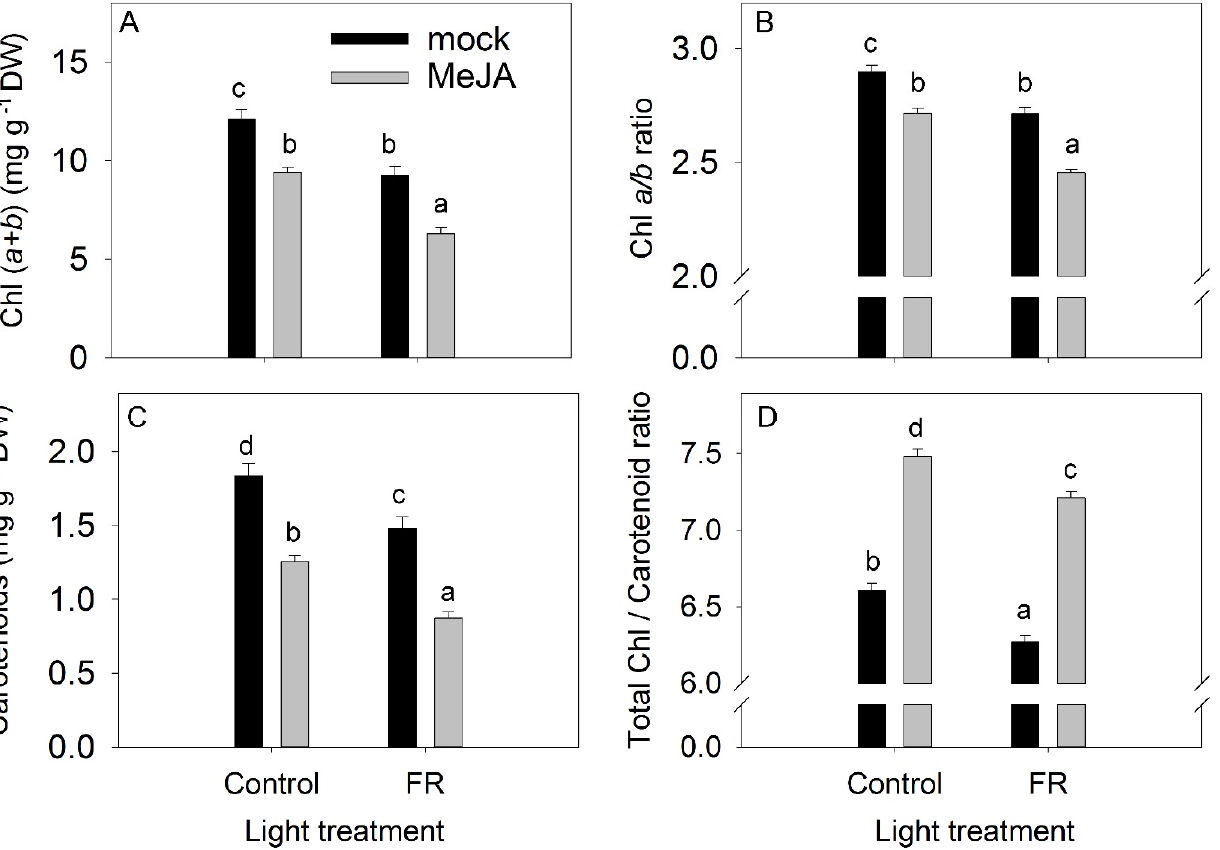
Figure 4. The effect of far-red light and methyl jasmonate (MeJA) application on total chlorophyll Chl ( a + b ) concentration ( A ), chlorophyll a / b ratio ( B ), carotenoid concentration ( C ), and total chlorophyll/carotenoid ratio ( D ) in Hypericum perforatum leaves. Differences between means with different letters are statistically significant. Light and jasmonate treatments were started at 36 days after sowing (DAS), and samples for measurements were taken at 65 DAS.